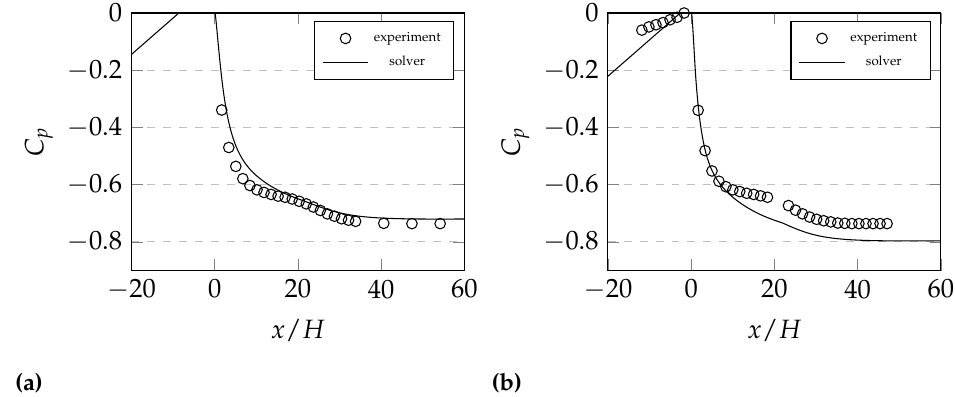
Figure 17. C f for the ( a ) top wall and the ( b ) bottom wall of the diffuser.